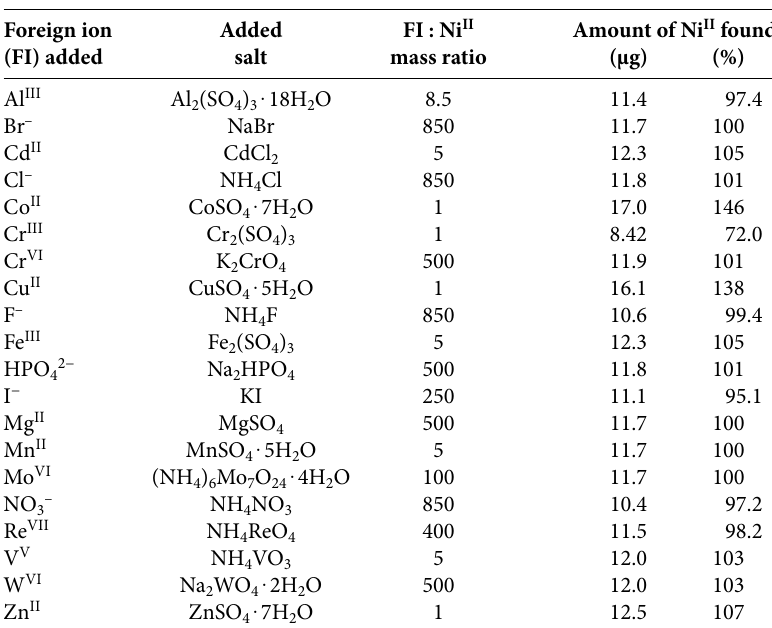
Figure 6. Determination of the MTAR/Ni II (1) and A336/Ni II (2) molar ratios by the mobile equilibrium method. The experimental conditions are given in Fig. 3 (series 2) and Fig. 4, respectively. Table 2. Effect of foreign ions in determination of 11.7 µg of Ni II